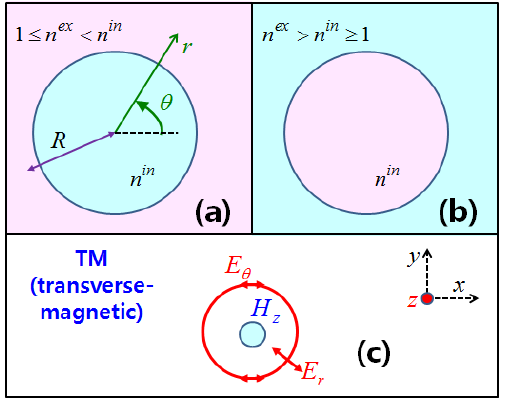
Figure 1: (a) A solid cylinder being optically denser than the exterior. (b) A cylindrical hole being optically rarer than the exterior. (c) A transverse magnetic (TM) wave under this study with non-zero field components.